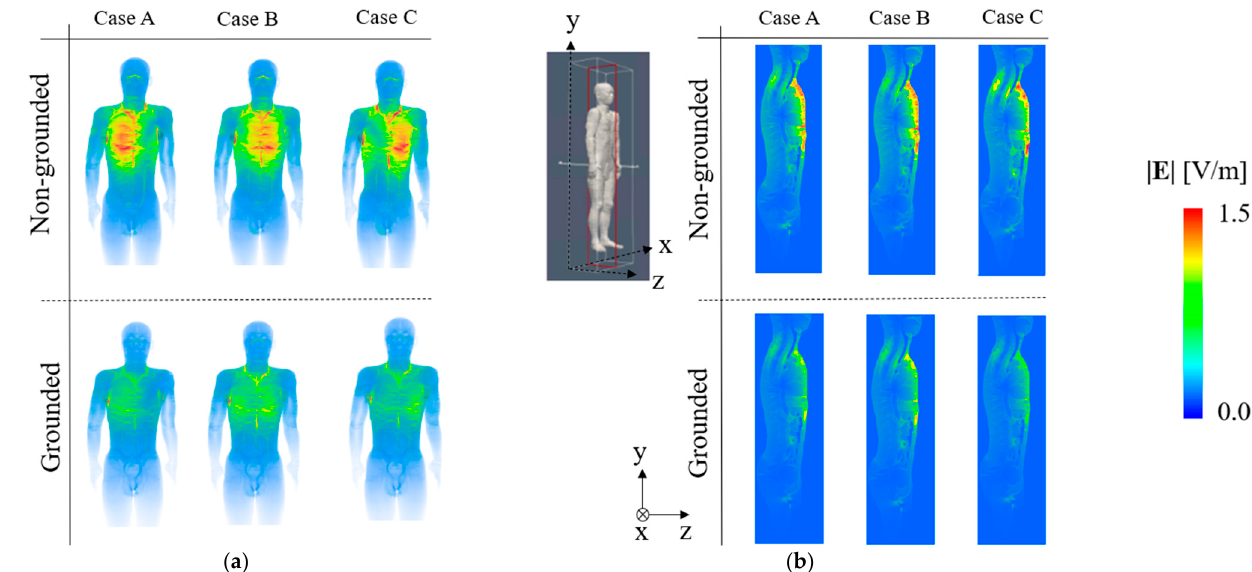
Figure 9. Induced electric field distribution on TARO. ( a ) Body surface. ( b ) Cross-sectional plane of input power 1 W, and transmission distance d = 9 cm.